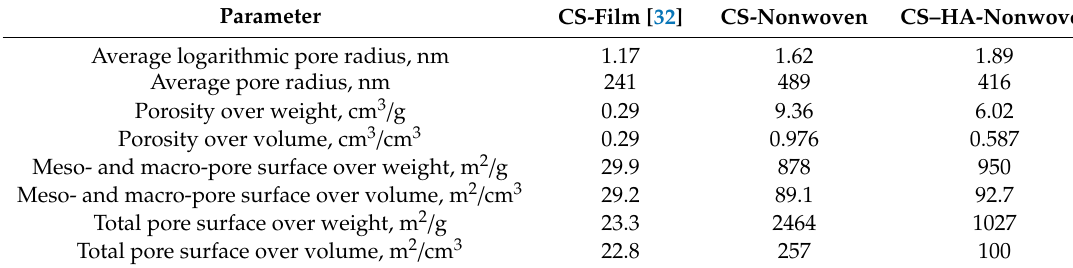
Table 2. Porosity of materials.